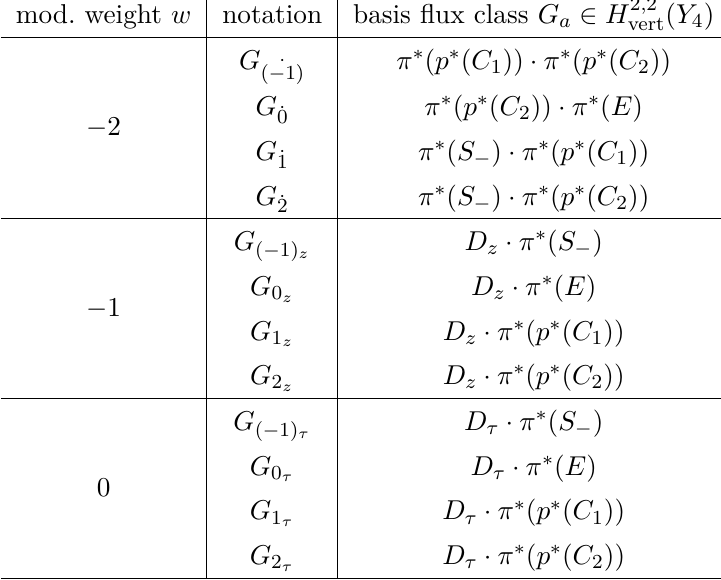
( Y ) for our example geometry, which is given by an elliptic fibration Table 1 . Basis of H 2 , 2 4 vert over B = dP P 1 . Indicated is also the modular weight of the associated partiton functions, 3 2 × l 0 Z w, ∗ [ G ∗ , C ∗ ]